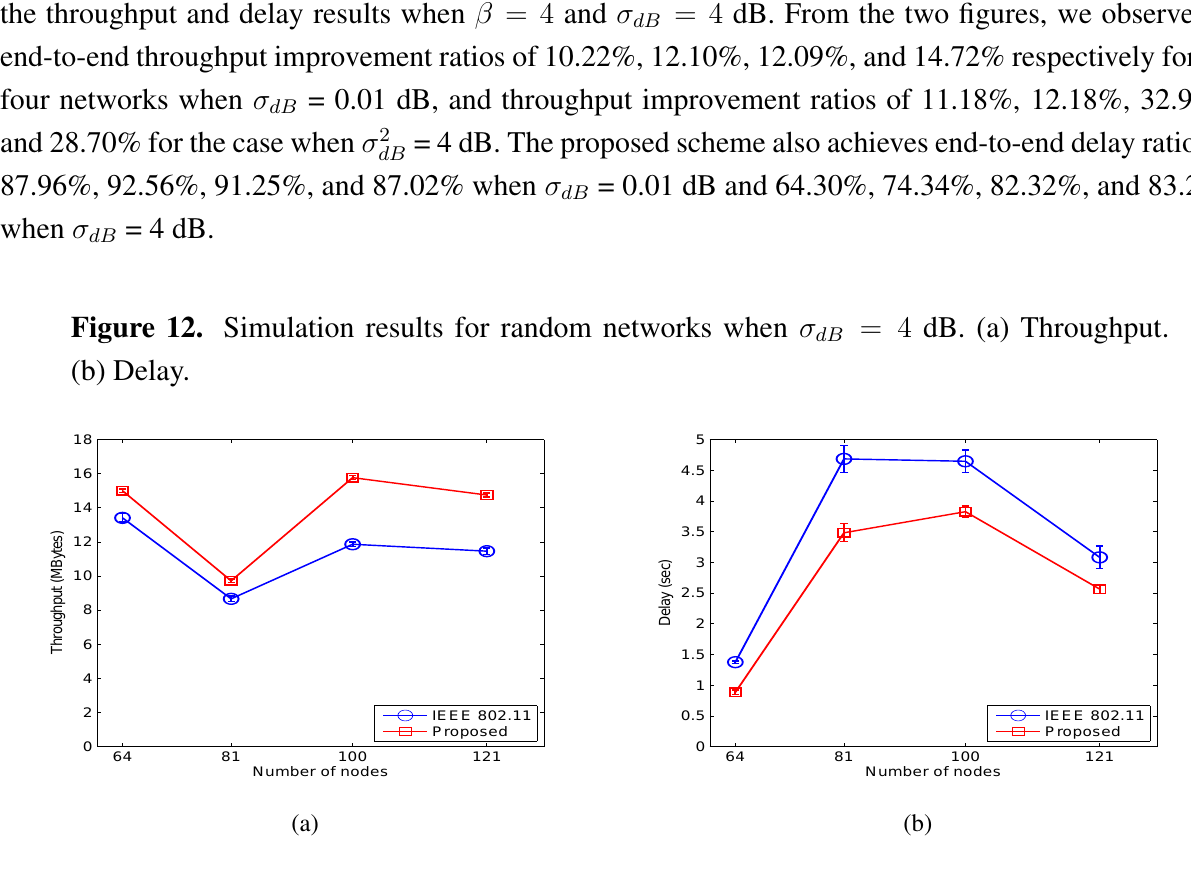
= 0 . 01 dB. (a) Throughput. dB